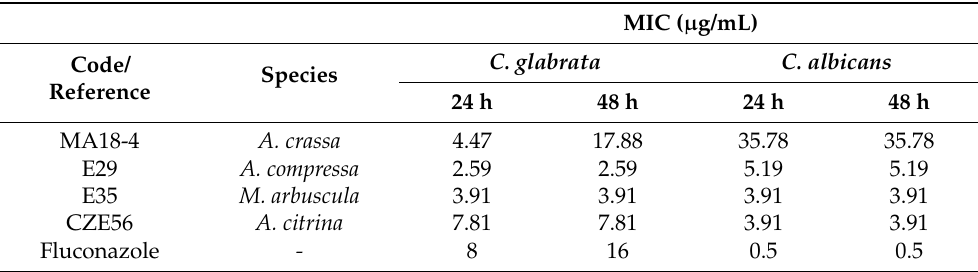
Table 2. MIC values ( µ g/mL) of the organic extracts of marine organisms from the Yucat á n Peninsula for C. albicans and C. glabrata .